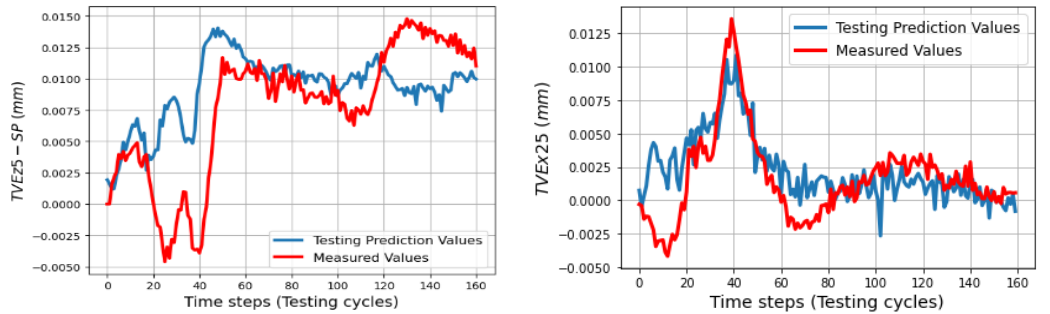
Figure 17. Prediction of TVEx5 and TVEy5 in the short process (SP) (1 cycle = 15 min) .